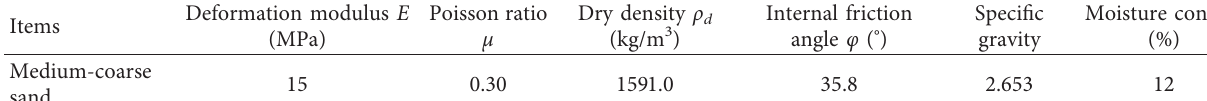
Table 1: Physical and mechanical property parameters of the medium-coarse